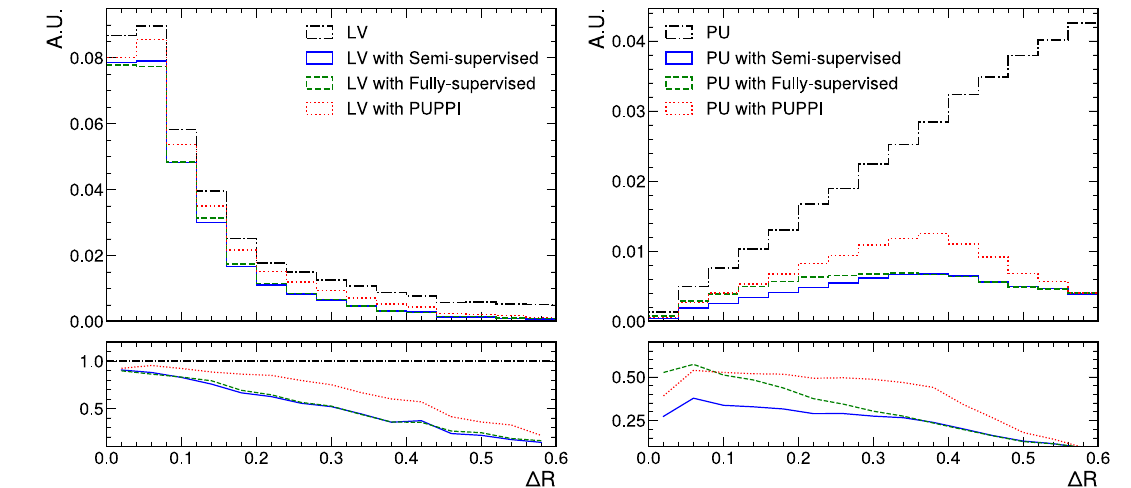
Fig. 8 The p T -weighted (cid:4) R distributions of the LV (left) and PU (right) particles locally to a truth-level jet